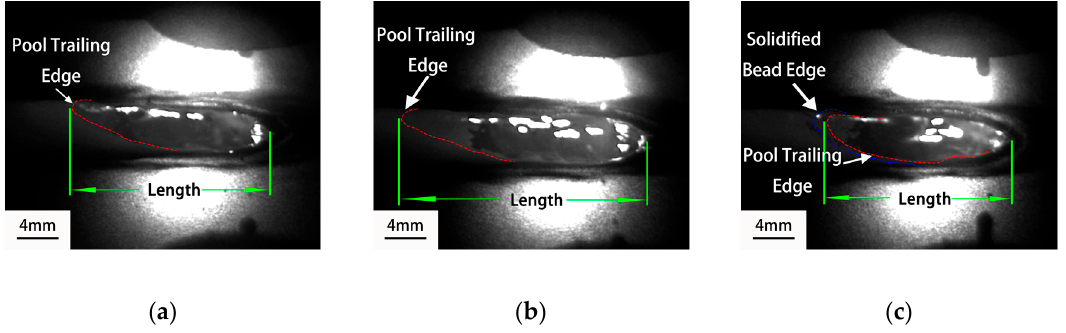
Figure 12. The variation of weld pool profile in thermal pulse: ( a ) P-GMAW (No.12); ( b ) peak period of thermal pulse of DP-GMAW (No.3); ( c ) Base period of thermal pulse of DP-GMAW (No.3).